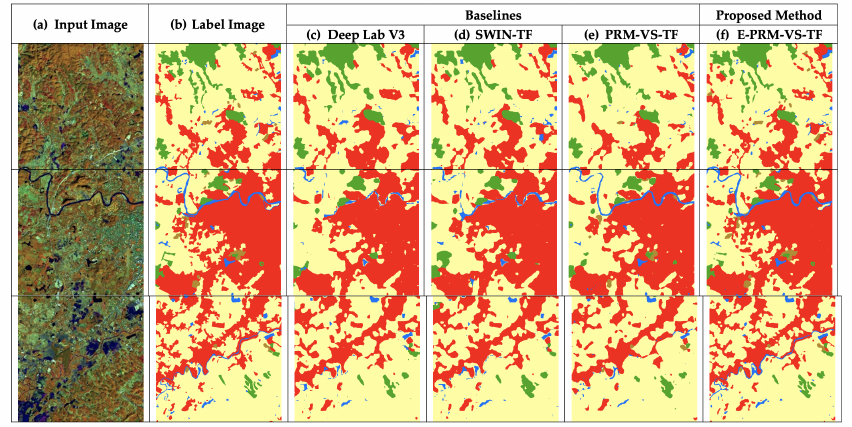
Figure 6. Comparison between the proposed method and baselines: focusing on the urban (red) and water (blue). The proposed method exhibits consistency in channels’ consequences.